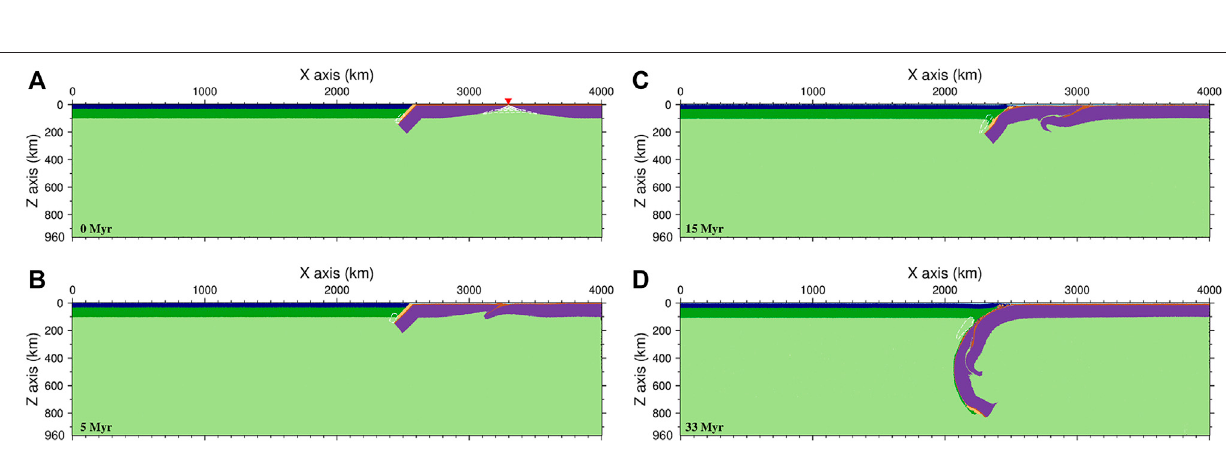
Frontiers in Earth Science |